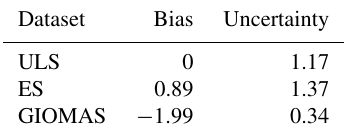
Table 1. The biases of GIOMAS and ES SIT relative to that of ULS and the uncertainties in SIT at ULS 206 (Unit: